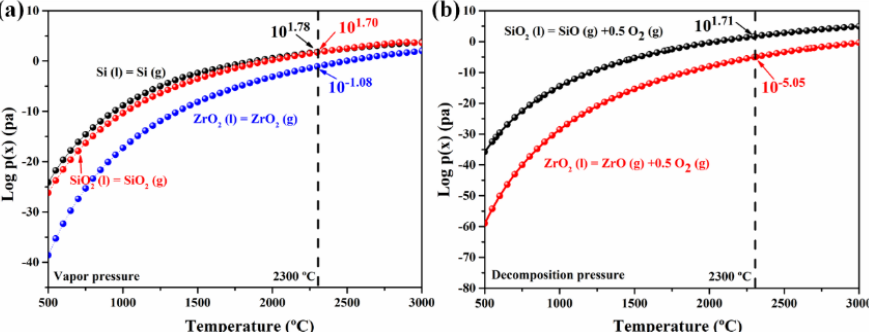
Figure 15. Vapor pressures ( a ) and decomposition pressures ( b ) for Si, SiO 2 , and ZrO 2 at 500–3000 °C .